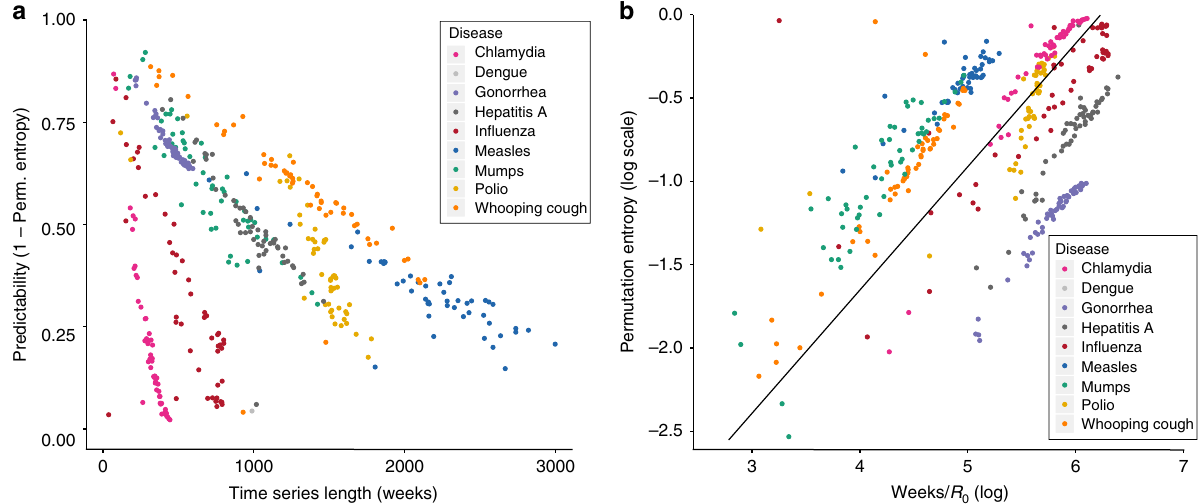
Fig. 3 Permutation entropy and time-series length show regularity by disease. a The predictability (1 − H p ) for chlamydia, dengue, gonorrhea, hepatitis A, in fl uenza, measles, mumps, polio, and whooping cough is plotted as a function of time-series length in weeks. Although the slopes are different for each disease, in all cases, longer time series, i.e. more data, result in lower predictability. However, we again fi nd that single outbreaks should be predictable and that diseases show a remarkable degree of clustering based on the slope of entropy gain. In this analysis, each dot represents the predictability for an entire state-level time series for a disease, i.e. the window size is the entire time series. b Rescaled time-series length based on the mean published basic reproductive number. Here we plot the log of time normalized by the basic reproductive number, i.e. R 0 , from the literature (see Supplementary Table 1) against the log of the permutation